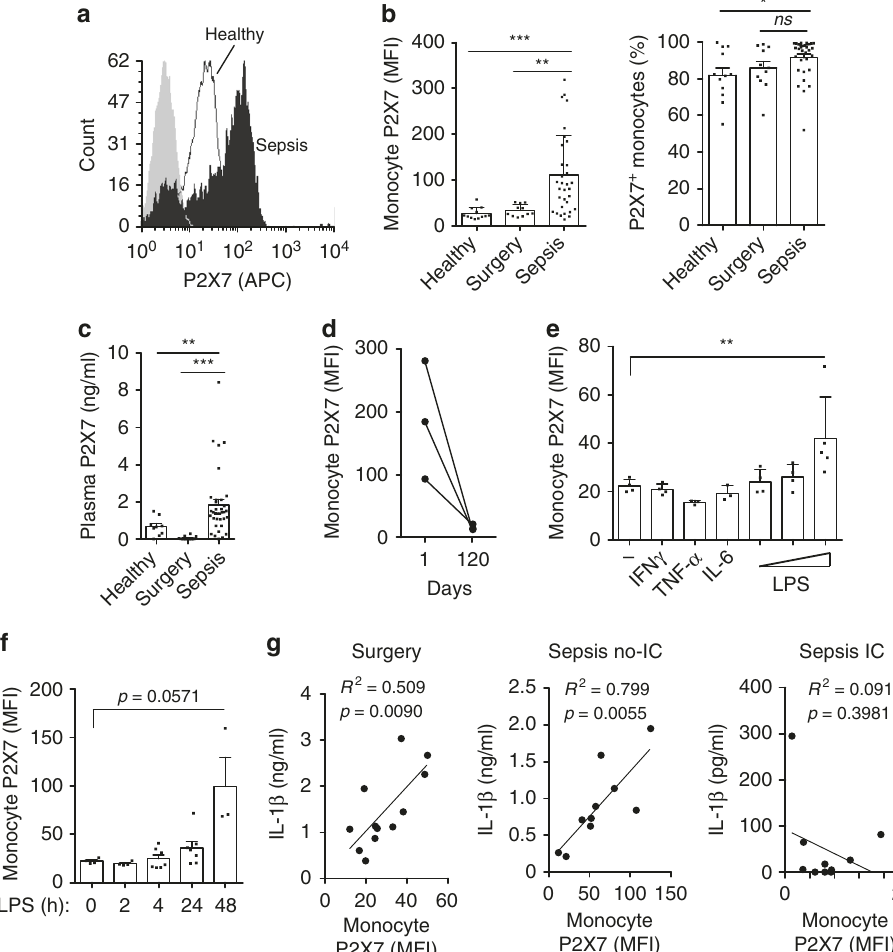
Fig. 4 P2X7 receptor is transiently upregulated in monocytes during sepsis. a Representative histogram plot of surface P2X7 receptor staining in monocytes from healthy (white), septic patient (black) and non-stained monocytes (gray). b Quanti fi cation of P2X7 receptor mean fl uorescence intensity (MFI, left) and percentage of positive monocytes for P2X7 receptor (right) in control and septic patients. c ELISA to quantify the concentration of soluble P2X7 receptor in plasma of control and septic patients. d Quanti fi cation of P2X7 receptor MFI at day 1 during sepsis and day 120 after recovery. e Quanti fi cation of P2X7 receptor MFI in monocytes from healthy donors treated with IFN γ , TNF- α , IL-6 (all at 20 ng/ml), or with increasing concentrations of LPS (10, 100, 1000 ng/ml) for 24 h. f Quanti fi cation of P2X7 receptor MFI in monocytes from healthy donors treated with LPS (1 μ g/ml) for the indicated times. g Correlation between the concentration of IL-1 β released from PBMCs treated with LPS (1 μ g/ml, 2 h) and ATP (3 mM, 30 min), and the quanti fi cation of P2X7 receptor MFI in monocytes from the indicated control and septic individuals; IC: immunocompromised septic patients. Each dot represents an individual septic patient or healthy donor; average ± standard error is represented in panels b , c , e , f ; exact n number for each panel is presented in Source Data fi le; * p < 0.05; ** p < 0.01; *** p < 0.001; ns , no signi fi cant difference ( p > 0.05); Kruskal – Wallis test was used in b ; Mann – Whitney test for c , e , f ; Pearson correlation was used in